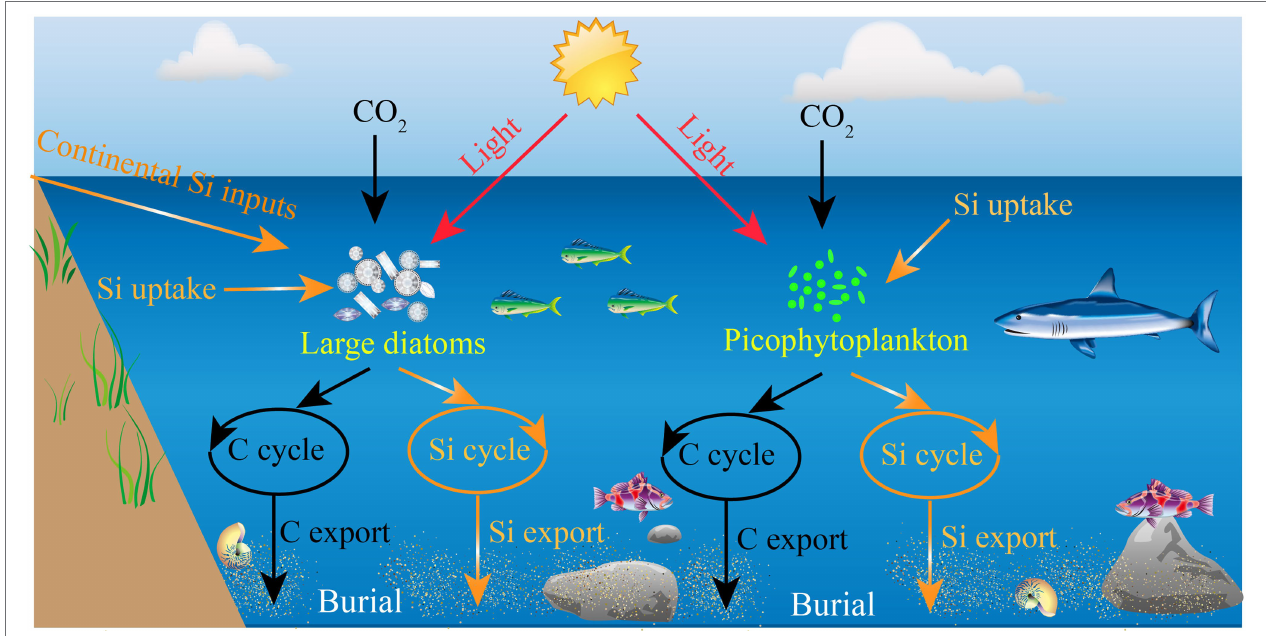
FIGURE 1 | Schematic view of the significance of large diatoms and picophytoplankton in the marine C and Si